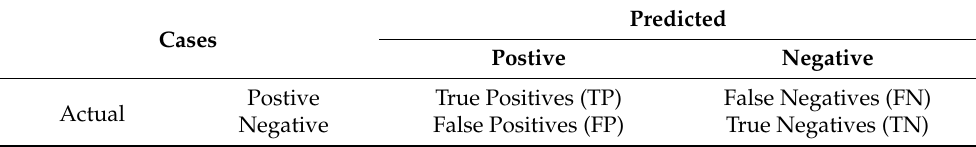
Table 5. Confusion matrix and performance